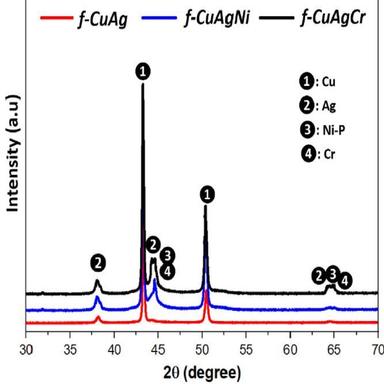
XRD patterns of two-layer f-CuAg powders versus f-CuAgNi and f-CuAgCr powders.